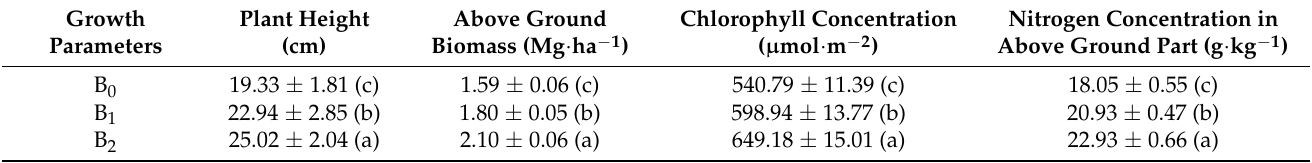
Table 1. Growth status of winter wheat under different basal fertilizer levels before topdressing.